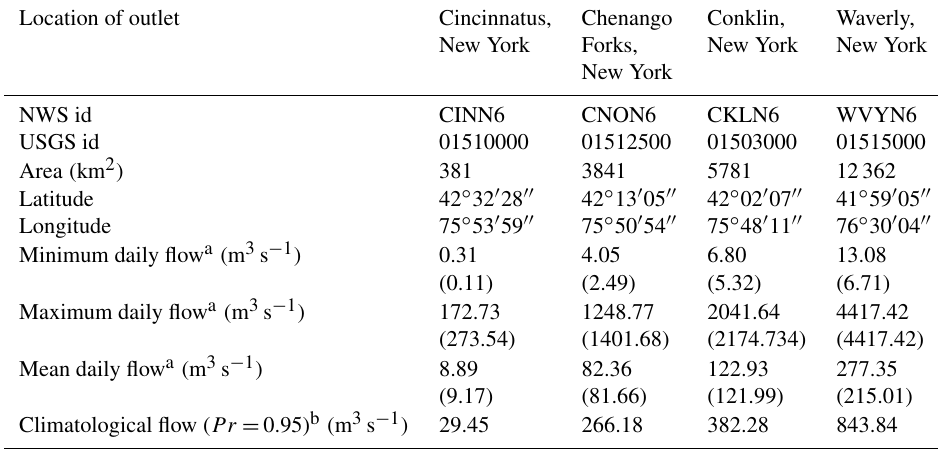
Table 1. Main characteristics of the four study basins. Location of